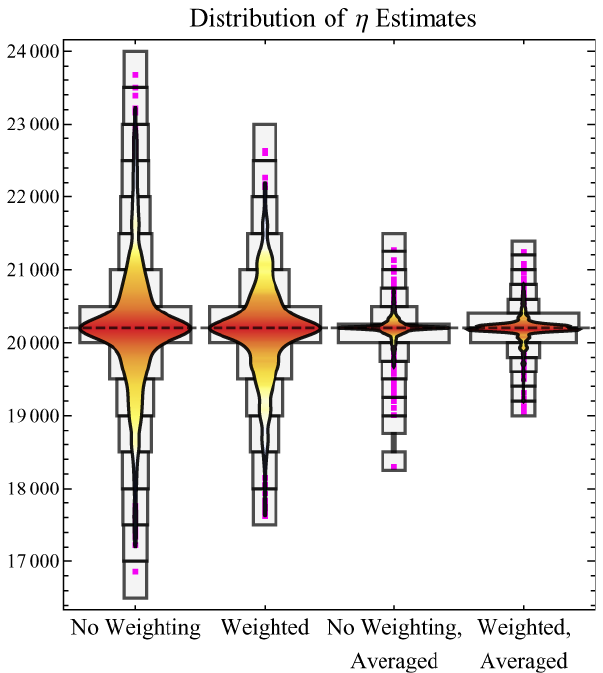
Fig. 9. Distribution of η 1 estimates. The dashed horizontal line indicates the true value.